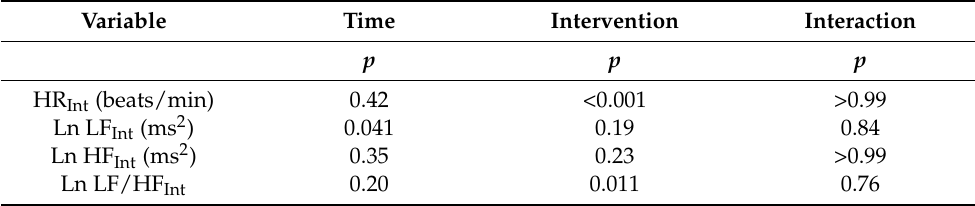
Table 2. Influence of low-frequency sound on heart rate variability indices during intervention.